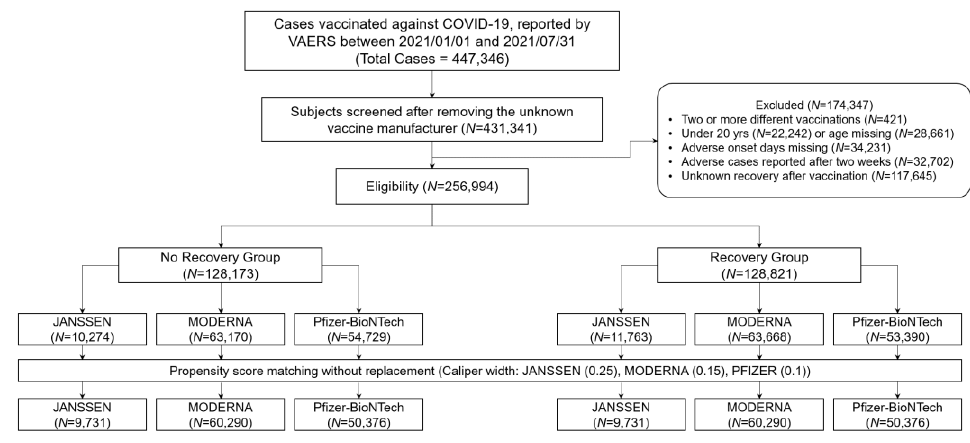
Figure 2. Study workflow.